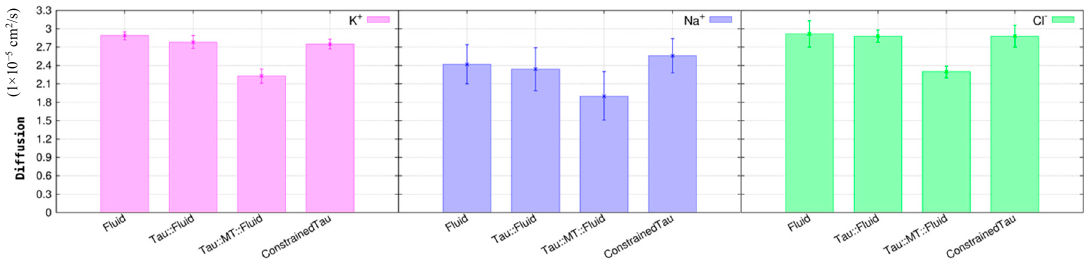
Figure 9. K + , Na + , and Cl − diffusion, D i (1 × 10 − 5 cm 2 /s), in the different systems under study: Neuron intracellular fluid (Fluid), tau in fluid (Tau::fluid), tau::microtubule in fluid (Tau::MT::Fluid) and constrained tau in fluid (ConstrainedTau).